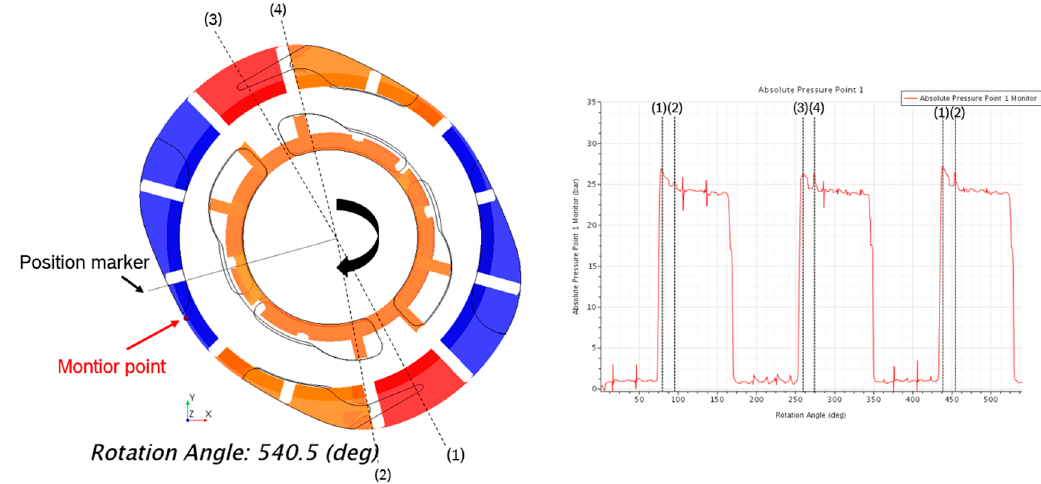
Figure 18. Correlation between pump geometry and the displacement chamber pressure of the monitor point. (1) Pressure surge after the groove of delivery port 1 connects to the displacement chamber. (2) Pressure surge, when connecting to delivery port 1. (3) Same as (1) for delivery port 2. (4) Same as (2) for delivery port 2.